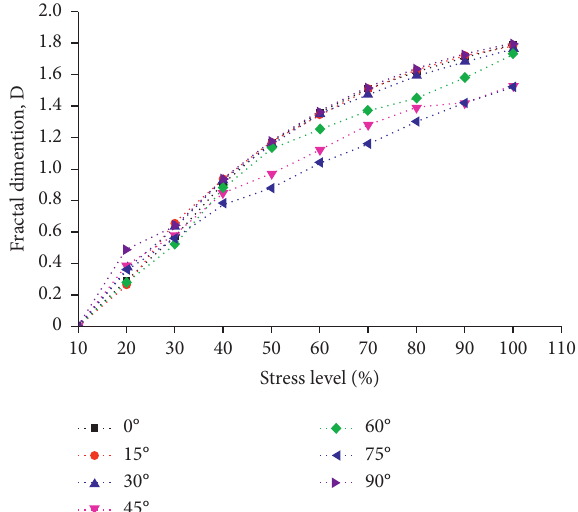
Figure 17: Relationship between distinct stress levels and fractal